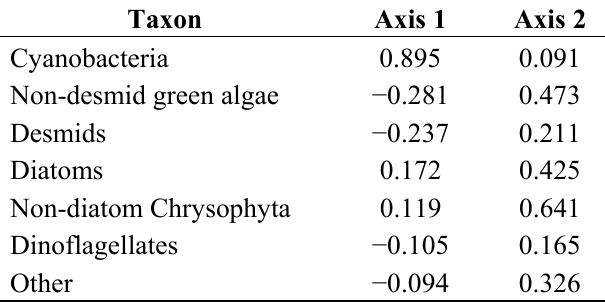
Table 1. Principal component analysis loading values for the 7-taxon matrix of phytoplankton counts for inner bay sites in Green